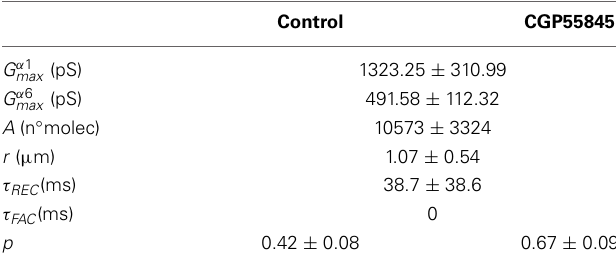
Table 2 | Model parameters obtained from eIPSC train fittings with the